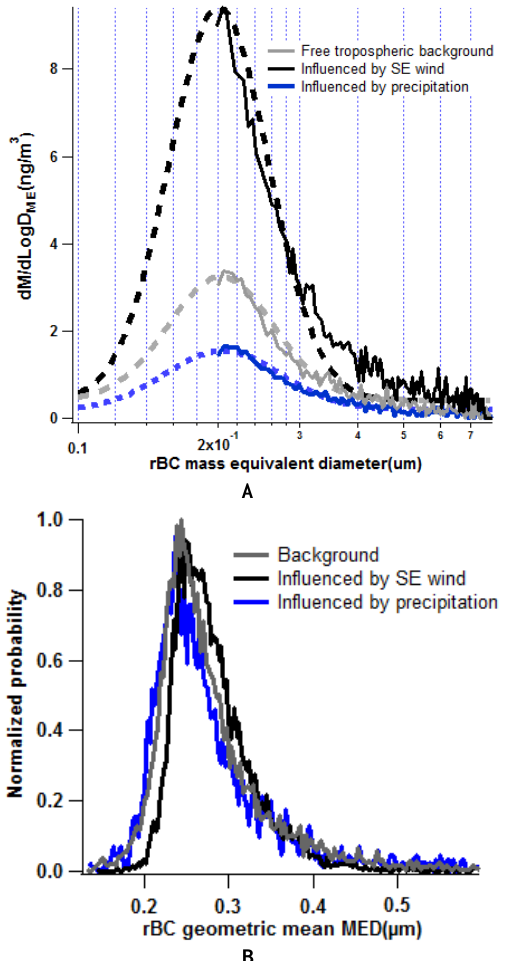
Fig. 8. (A) Mean rBC mass size distribution measured (solid lines) under different conditions. The dotted lines show the lognormal fittings on the measured size distributions to derive the total mass loadings. (B) The occurrence frequencies of geometric mean MED for rBC core under different conditions.